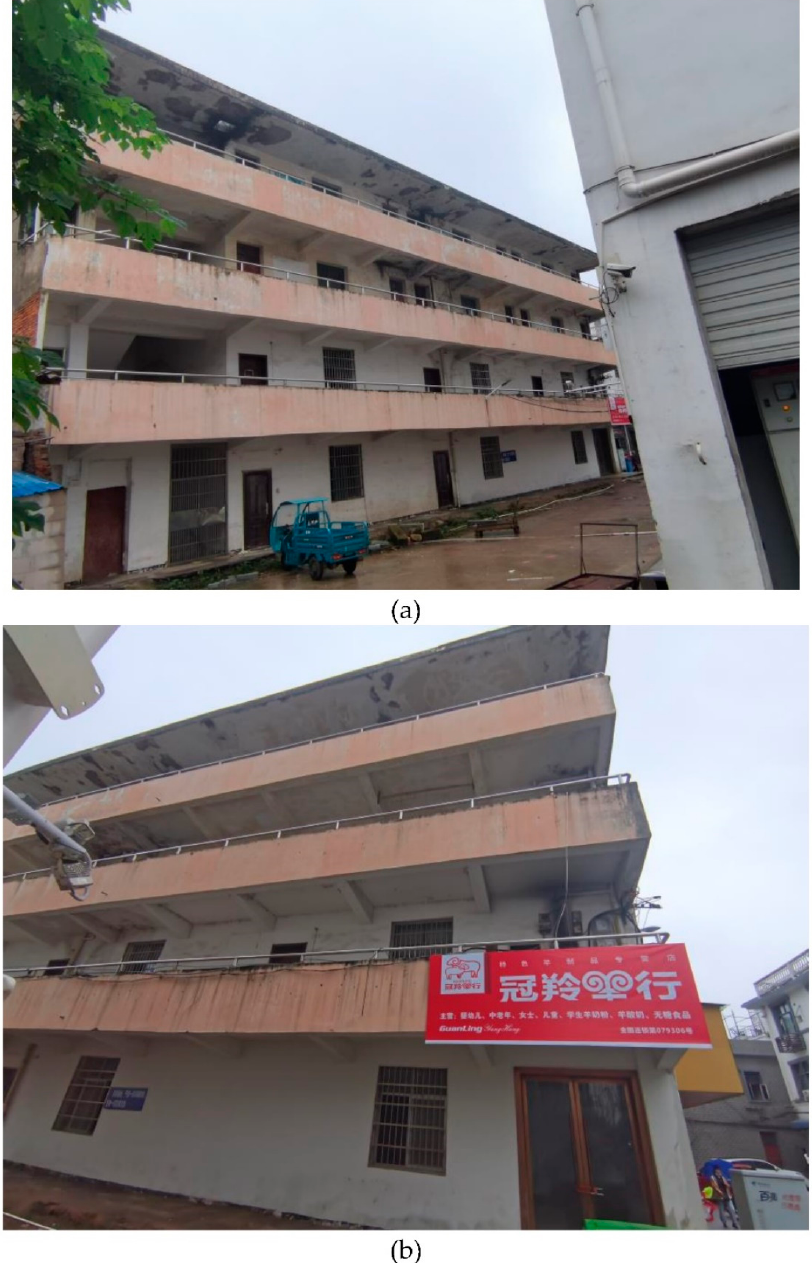
Figure 7. An example of a typical idle school building in China. (The content shown in ( a ) in